Question: Generate an informative caption for the figure above.
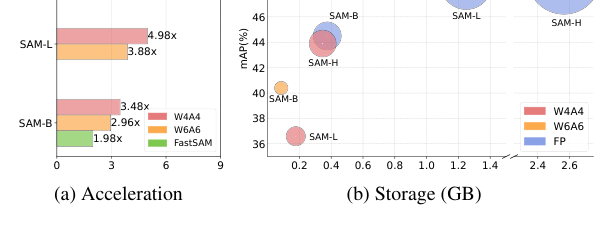
Answer: (a) Theoretical acceleration rate (100 prompts) vs. all SAM models. (b) Accuracy vs. storage.